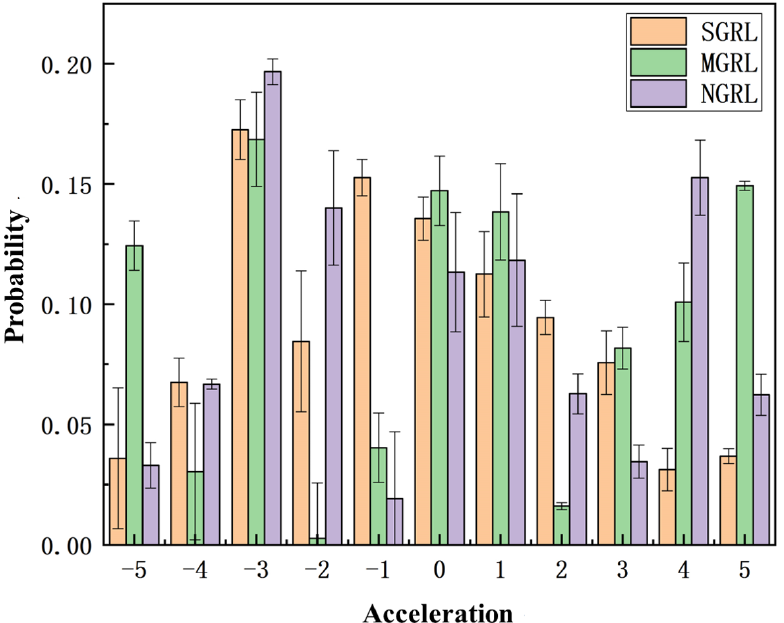
Figure 20. Spatial distribution diagram of longitudinal movement. Based on the frequency statistics of each action output in each testing process, the probability distribution of the longitudinal action can be obtained through probability calculation. The data in the figure are obtained from the average of ten repeated experiments.